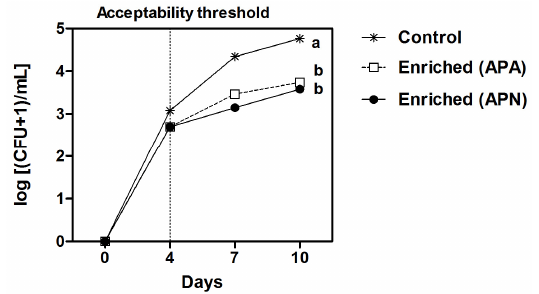
Figure 4. Total viable counts of tomato juices with added phenolic extracts (neutral, APN; acidic, APA) compared to control during the storage time of 10 days at 4 °C. The acceptability threshold at day 4 is indicated with a dotted line. Different letters indicate significant differences ( p < 0.05) between samples. CFU, colony forming unit.